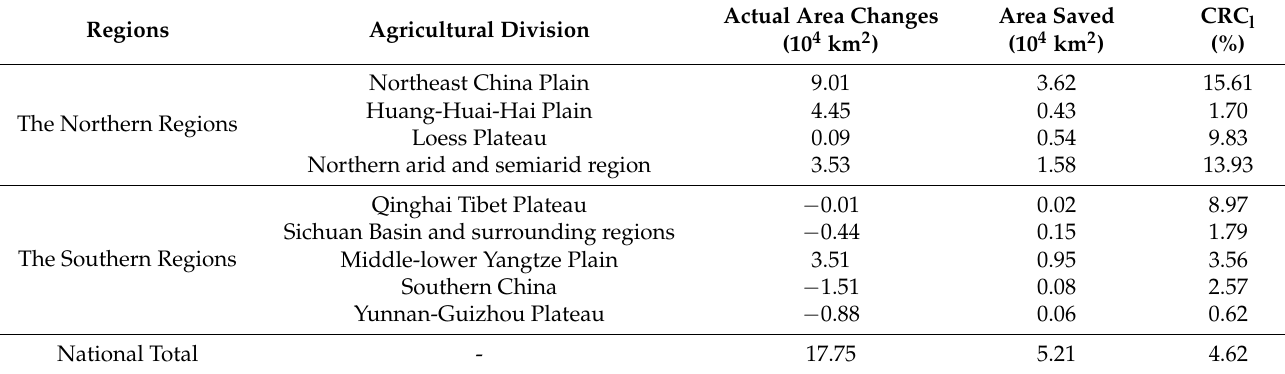
Table 1. Effect of grain planting structure adjustment on cropland resources consumption during 2003–2019. Regions